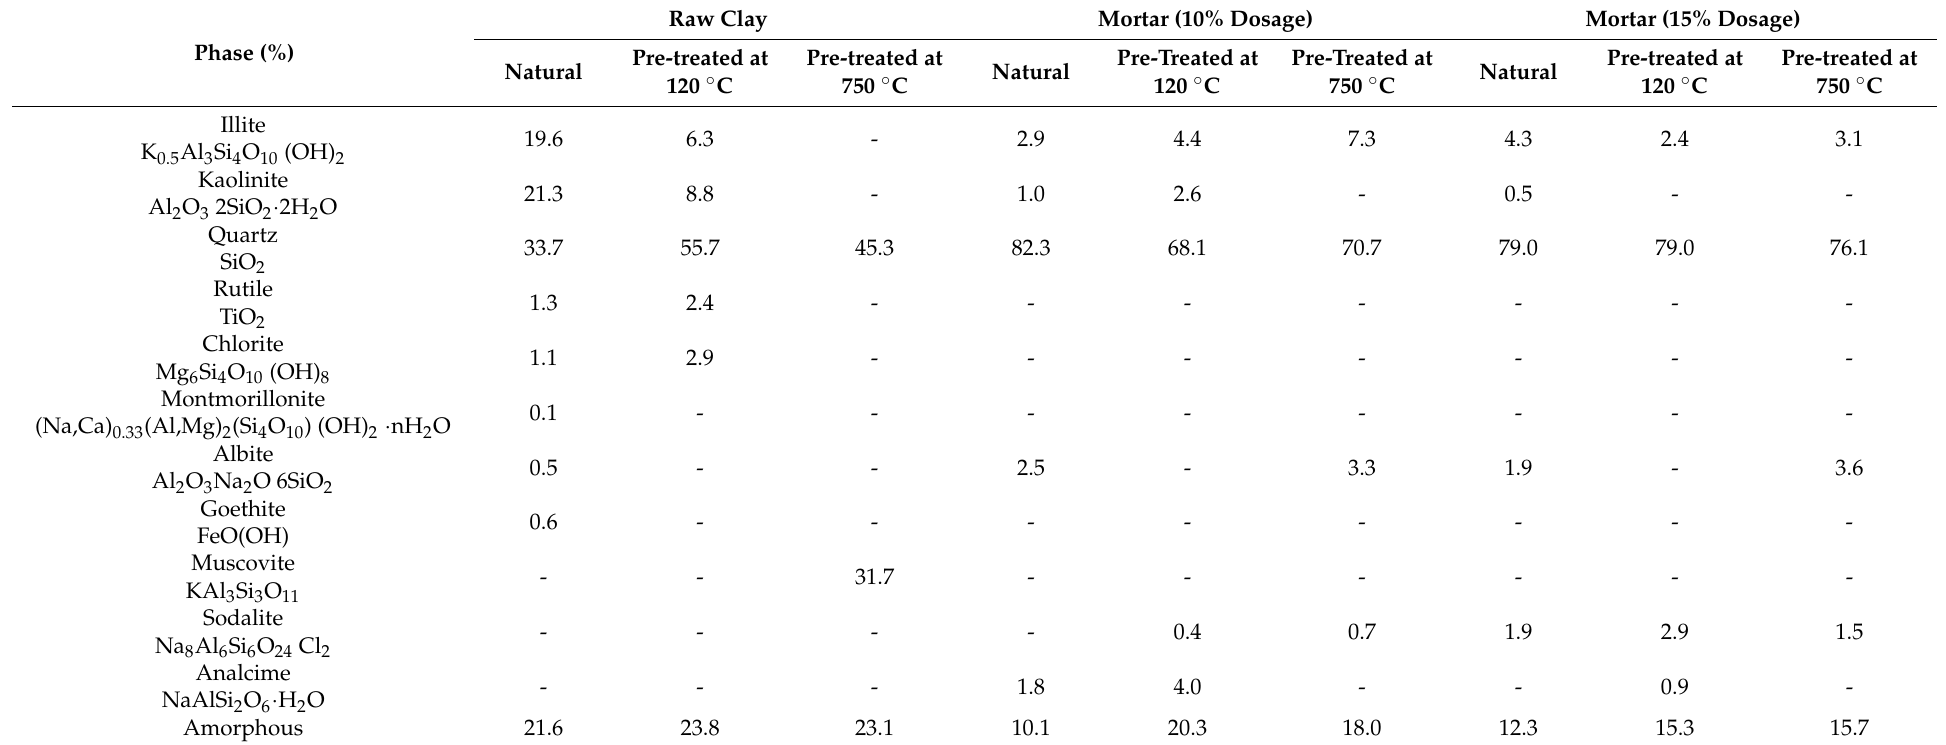
Table 4. Mineralogical composition of clay and alkali-activated mortar at 28 days (AM 1.0, dosages of 10% and